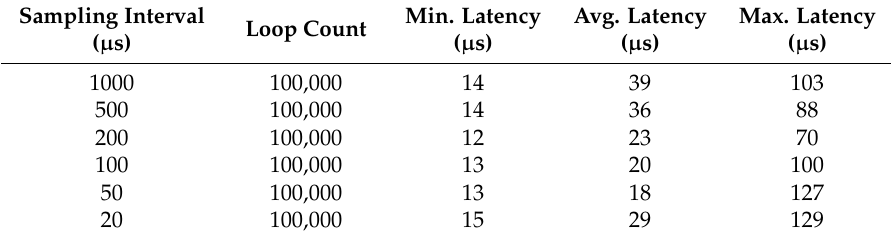
Table 3. Latency as reported by cyclictest on the prototype